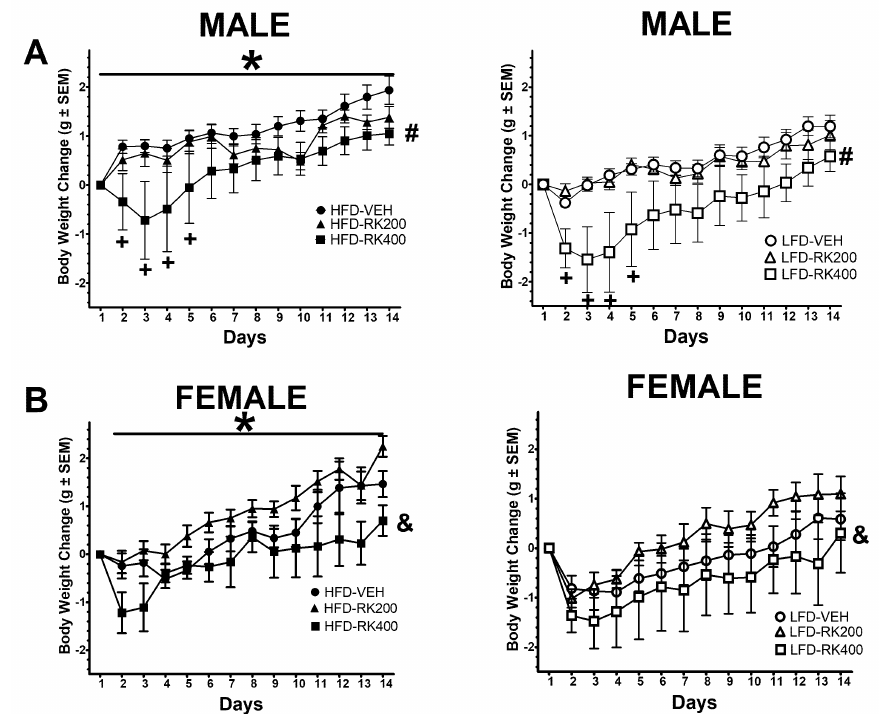
Figure 1. Body weight change in grams over the 14 days of diet access and oral RK dosing compared with baseline. Data are represented as means ± standard error of the mean (SEM). High-fat diet (45% fat; HFD, solid symbols) and low-fat diet (10% fat; LFD, open symbols) and oral gavage with raspberry ketone (RK) or vehicle (50% propylene glycol, 40% water, and 10% dimethyl sulfoxide; DMSO) for 14 days. Comparisons are separate within each sex. ( A ): Males, ( B ): Females. * indicates overall diet difference from LFD ( p < 0.05), # indicates overall difference from all other doses ( p < 0.05), + indicates overall daily dose difference from VEH dose ( p < 0.05), & indicates overall dose difference from 200 mg / kg dose ( p < 0.05). HFD-Vehicle (males: n = 16, females n = 8), HFD-RK (200 mg / kg) (males: n = 8, females: n = 8), HFD-RK (400 mg / kg) (males: n = 8, females: n = 7), LFD-Vehicle (males: n = 16, females: n = 8) LFD-RK (200 mg / kg)(males: n = 8, females: n = 8), and LFD-RK (400 mg / kg)(males: n = 8, females: n =